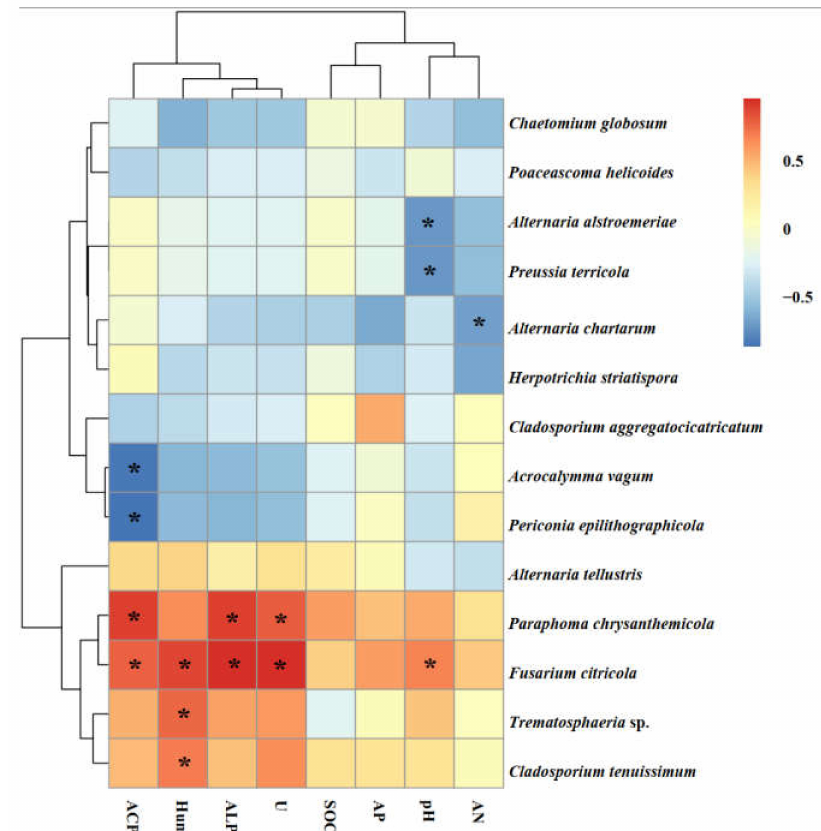
Figure 6. Heat maps of the correlation analysis between soil factors and the roots relative abundance of isolated endophytes. Note: ACP, soil acid phosphatase. Hum, soil moisture. ALP, soil alkaline phosphatase activities. U, soil urease. SOC, soil organic matter. AP, soil available phosphorus. AN, soil available nitrogen. The asterisks indicate significant correlations at p <